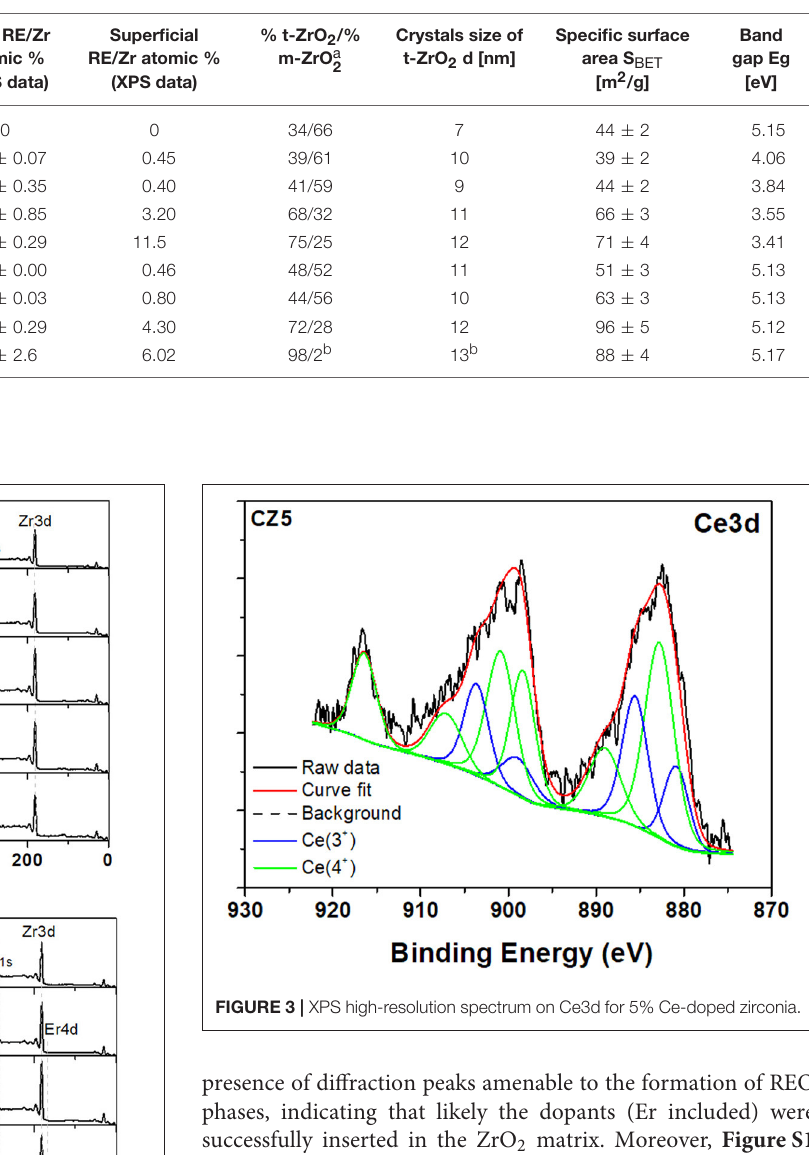
TABLE 1 | Chemico-physical characteristics of doped and non-doped ZrO 2 samples theoretically calculated and obtained from XPS, FESEM-EDS, XRD, UV-Vis spectroscopy, and N 2 absorption measurements.